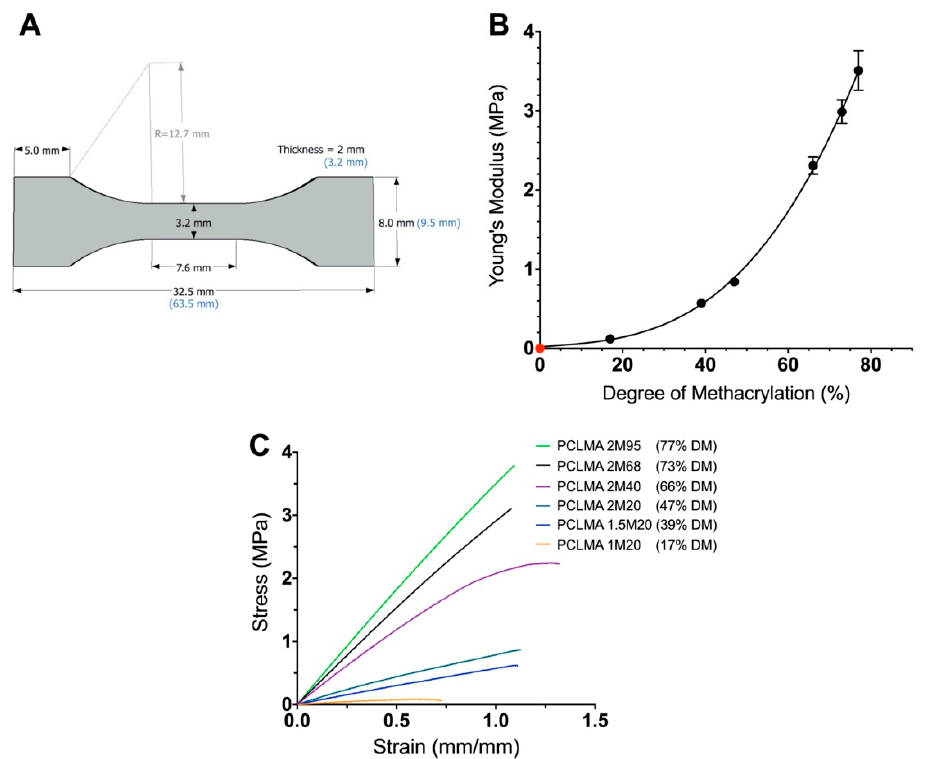
Figure 3. The effect of the degree of methacrylation on the Young’s modulus of the cured PCLMA. ( A ) specifications of the tensile test piece adapted from the ASTM D638 ‐ 14 ‘Standard Test Method for Tensile Properties of Plastics’ Type V specimen; ( B ) the Young’s modulus of cured PCLMA plotted against the degree of methacrylation of the prepolymer. Values displayed mean ± SD, N = 1, n = 4–7. (N.B. The SD in the 17%, 39% and 47% DM is too small for the error bars to be visible.) The point in red signifies a theoretical (0,0) representing a 0 MPa Young’s modulus for 0% DM PCLMA (since curing of solid structures to test under tensile loading is not possible). Cubic polynomial regression curve fitted (R 2 = 0.99). ( C ) example stress–strain curves of each of the PCLMA samples.